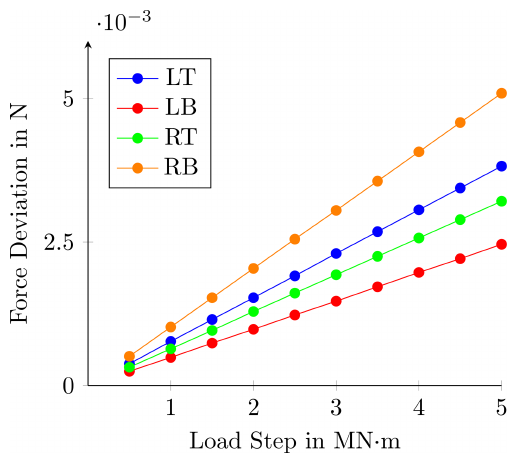
Figure 9. Bending moment deviation influence on the FT measure-